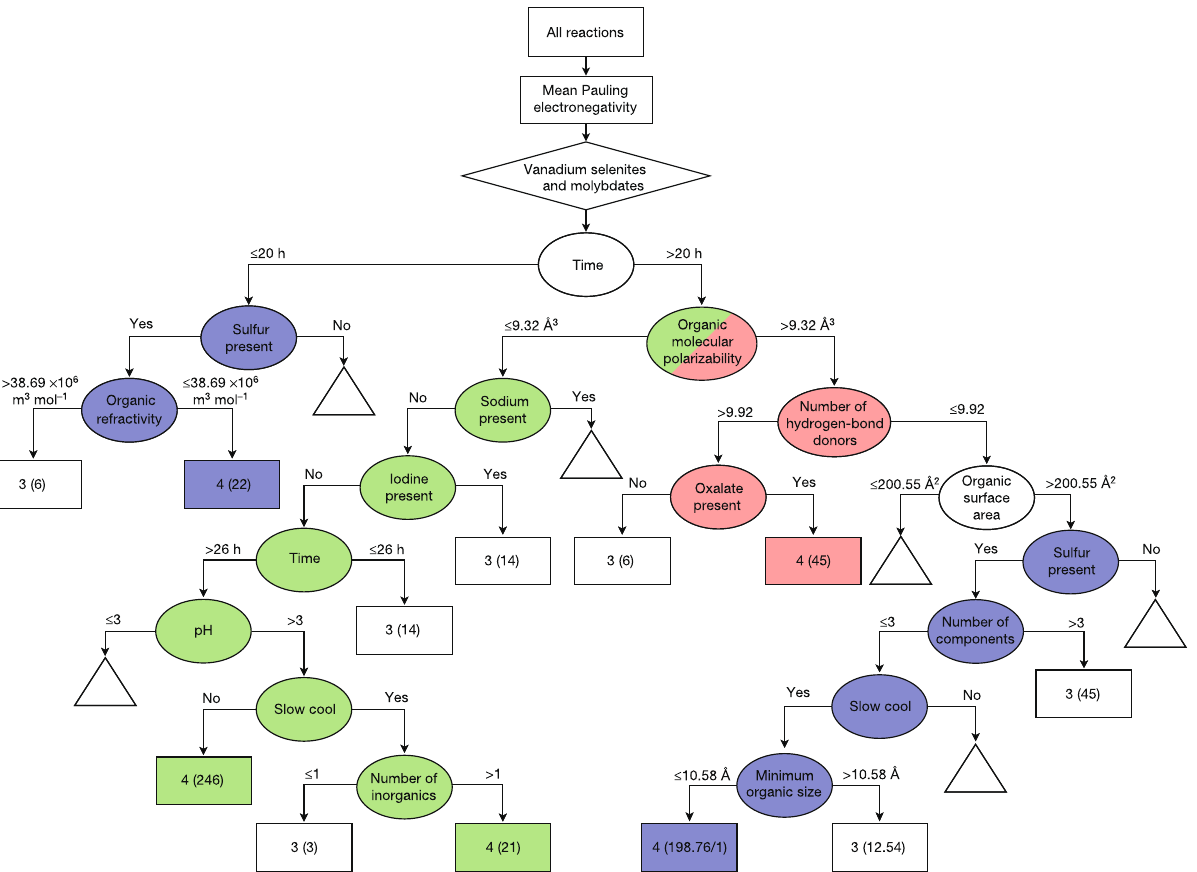
Fig. 7 Example surrogate decision tree model. The task is to predict reaction successes from tabular input data, for which a SVM model achieves good accuracy. A surrogate tree is then built using original SVM model predictions to help understand the original model. The surrogate tree is shown above. Ovals represent decision nodes. Rectangles represent reaction-outcome bins. Triangles represent excised subtrees. Each reaction-outcome bin contains a reaction-outcome value (3 or 4) and the number of reactions assigned to that bin (shown in parenthesis). Bins containing the most successful reactions and their associated synthesis paths are identi fi ed and colored. The authors generate the following new testable chemical hypotheses by inspecting the green, blue and red subtrees: (1) Small, low-polarizability amines require the absence of competing Na + cations and longer reaction times. (2) Spherical, low projection-size amines require V 4 + -containing reagents such as